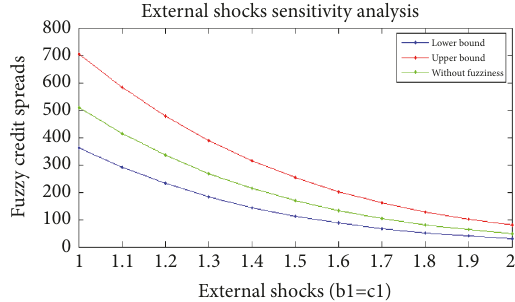
Figure 2: The dynamics between fuzzy credit spreads and fuzzy degree of external shocks.